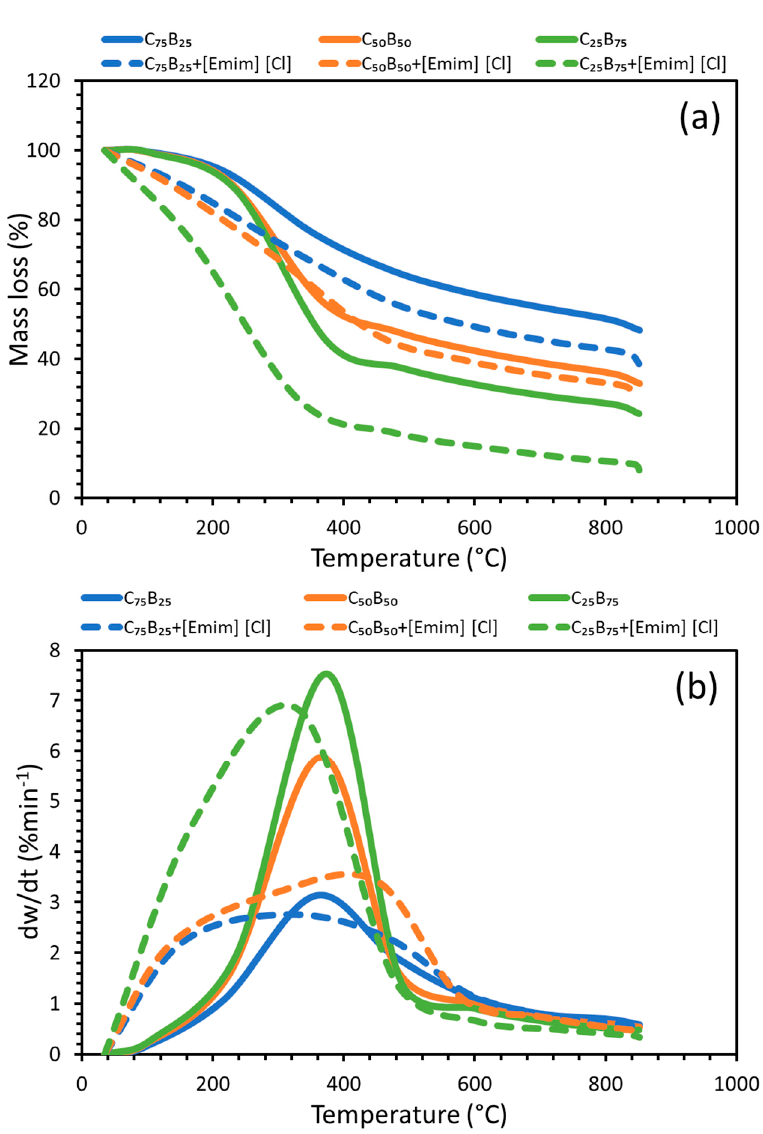
Figure 1. ( a ) TG and ( b ) DTG profiles of untreated and [Emim][Cl] treated coal SCB blends.